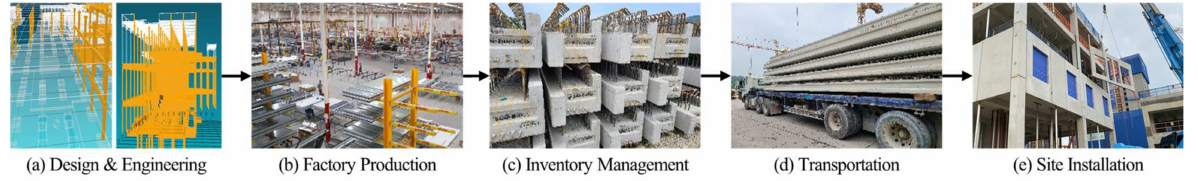
Figure 2. Supply chain in OSC production